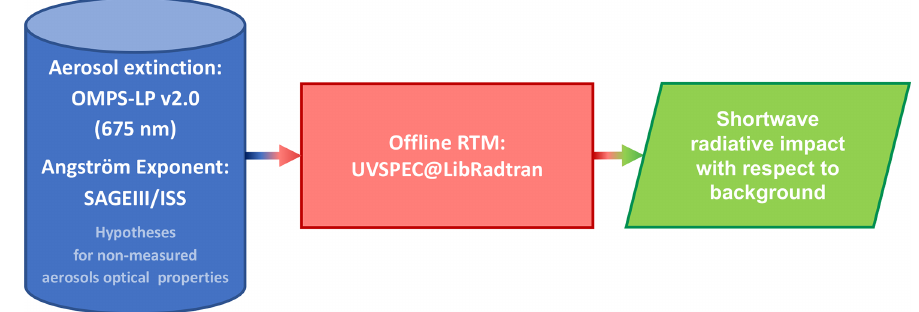
Figure 1. Scheme of the offline radiative transfer modelling used in this work.